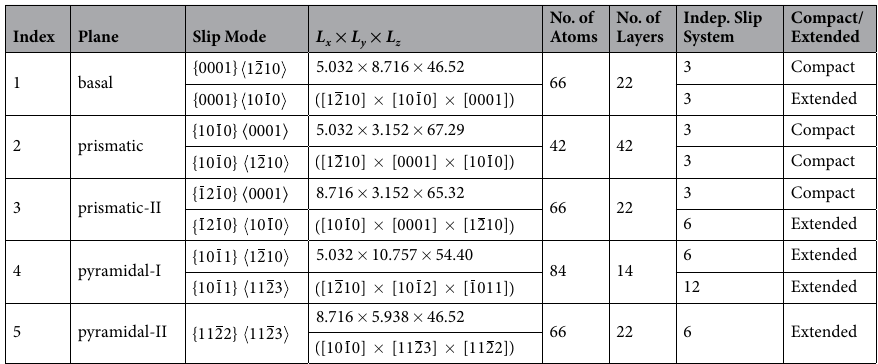
Table 2. Details of the supercells used in the calculation of the GSFE curves for each slip mode. The fourth column shows the dimensions (in Å ) and the crystallography of the supercell along the x, y and z directions. The sixth column shows the number of layers in the model normal to the slip plane and the eighth column shows whether the full dislocation is compact or extended in a dissociated